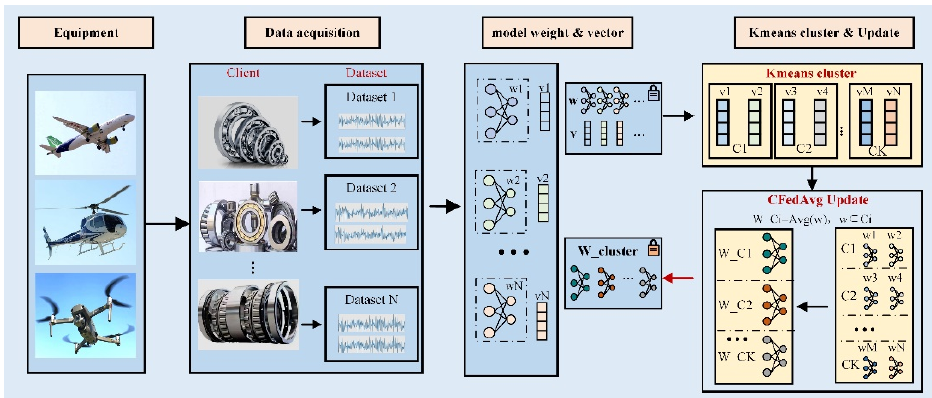
Figure 2. Overall program flowchart of CFL.